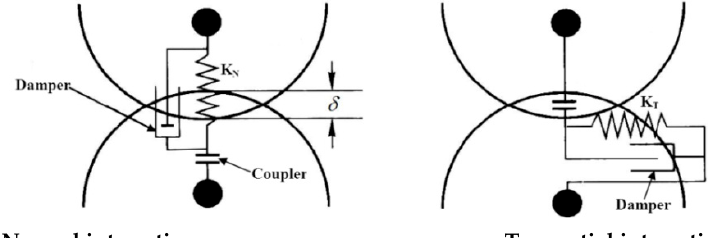
Figure 3. Simplified representation of contact force of soft sphere model.